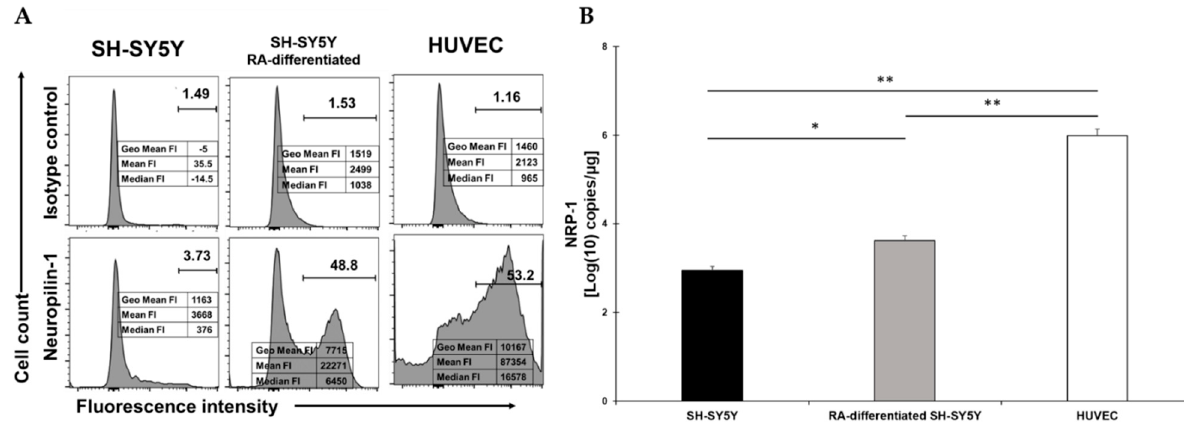
Figure 3. ( A ) Flow cytometry analysis of NRP1 expression in SH-SY5Y (left), RA-differentiated SH-SY5Y (middle), and HUVEC (right) cells. Both SH-SY5Y and HUVEC cells were stained with the specific antibody for the receptor (bottom) or the corresponding isotype control (top). The data related to the fluorescent intensity are also indicated in the figure. A representative of three different experiments is shown. ( B ) mRNA expression levels of NRP1 in both SH-SY5Y and RA-differentiated SH-SY5Y and HUVEC cells. Experiments were done in duplicates. Copy number per µg of mRNA is indicated. * p < 0.05 and ** p < 0.01.